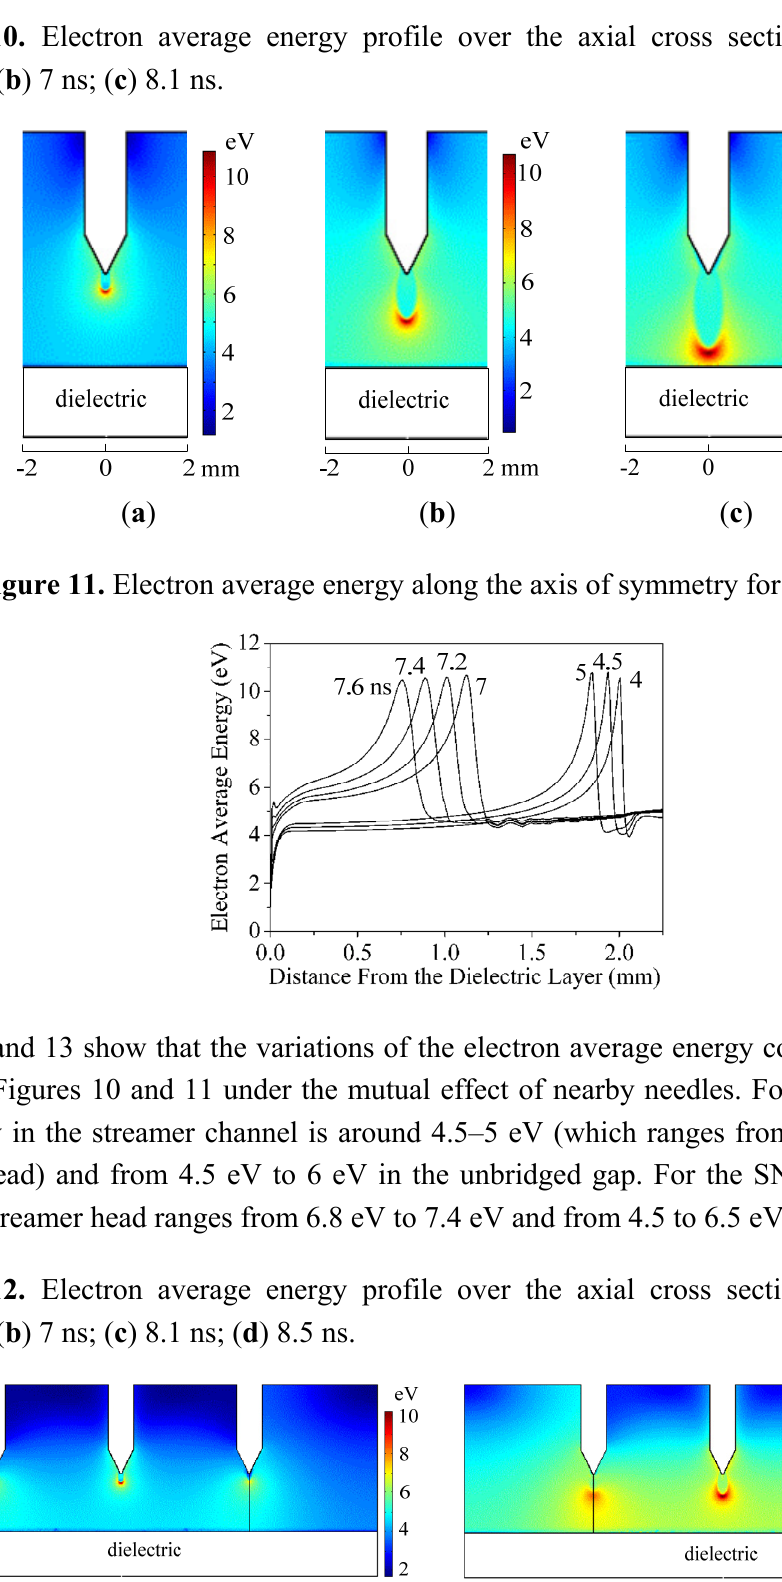
Figure 10. Electron average energy profile over the axial cross section of the SNG: